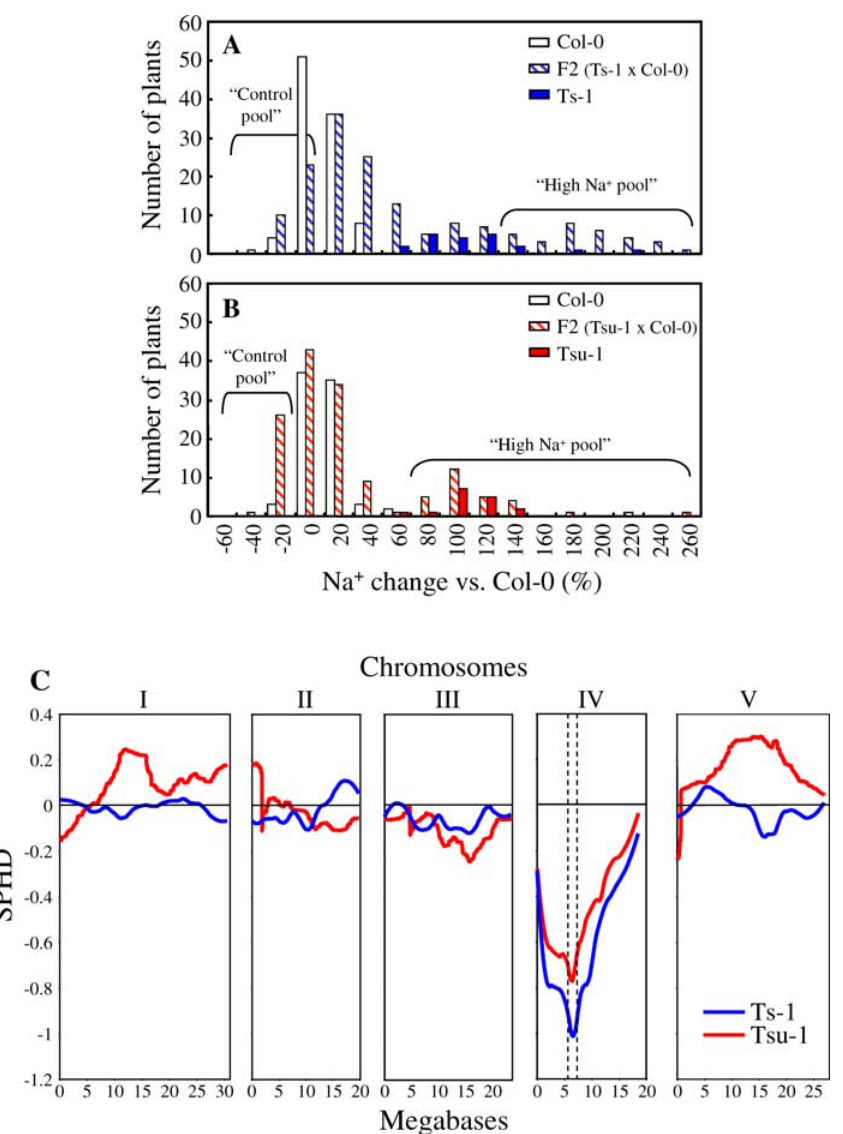
Figure 2. The Higher Na þ Accumulation in Shoots of Ts-1 and Tsu-1 Is a Monogenic Recessive Trait Caused by a Gene Located on Chromosome IV (A) Distribution of Na þ accumulation in shoot tissue of F2 segregating population obtained from crossing Col-0 with Ts-1. Presented data are distribution of Col-0 ( n ¼ 99), Ts-1 ( n ¼ 20), and F2 (Ts-1 3 Col-0) ( n ¼ 158) plants. (B) Distribution of Na þ accumulation in shoot tissue of F2 segregating population obtained from crossing Col-0 with Tsu-1. Presented data are distribution of Col-0 ( n ¼ 80), Tsu-1 ( n ¼ 16), and F2 (Tsu-1 3 Col-0) ( n ¼ 143). Na þ contents were calculated for each plant as a percentage relative to Col- 0 average Na þ content. The ‘‘ Control pool ’’ and ‘‘ High Na þ pool ’’ labels indicate the F2 plants used to prepare the corresponding DNA pools for the DNA microarray-based BSA. (C) Hybridization of genomic DNA from Ts-1 (blue) and Tsu-1 (red) to DNA microarray (ATH1). Data are presented as a Scaled pool hybridization difference (SPHD), the difference between the hybridization of the two pools at the SFPs, scaled so that the difference between Col-0 and the accession would be equal to 1. SFPs were selected based on their D -statistic, which is a modified t -statistic that avoids spurious large values due to low hybridization levels [12]. Dashed vertical lines on Chromosome IV represent the mapping confidence interval of 0.875 Mbp on either side of the peak. Confidence intervals were calculated using algorithms derived from simulations by Borevitz et al. [12], and the scripts accessed at http://www.